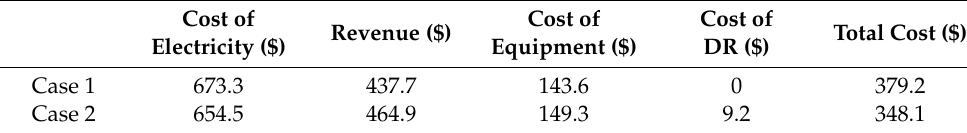
Table 4. Operation costs of EMS in two cases.